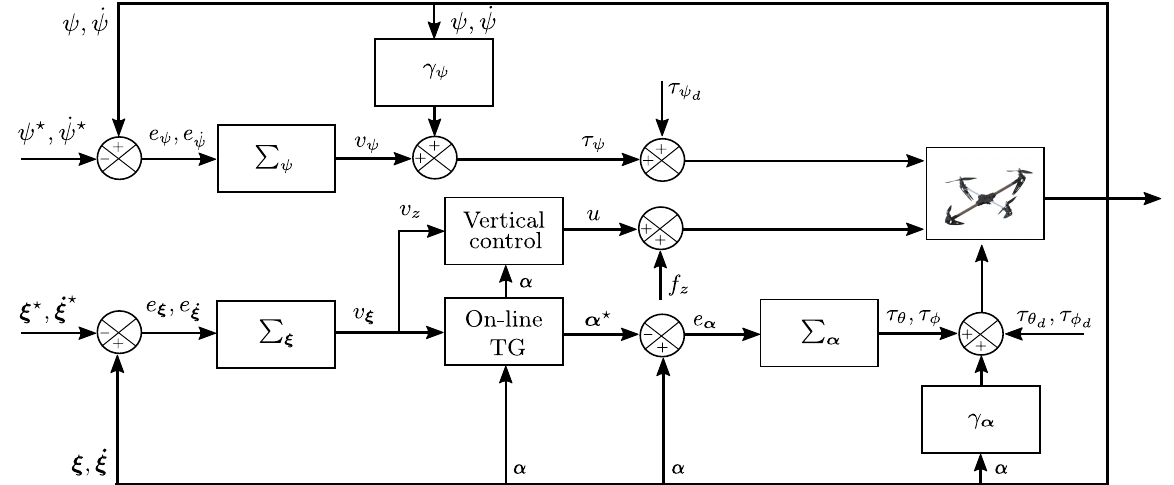
Figure 2. Desired motion tracking control scheme based on virtual dynamic vibration absorbers.